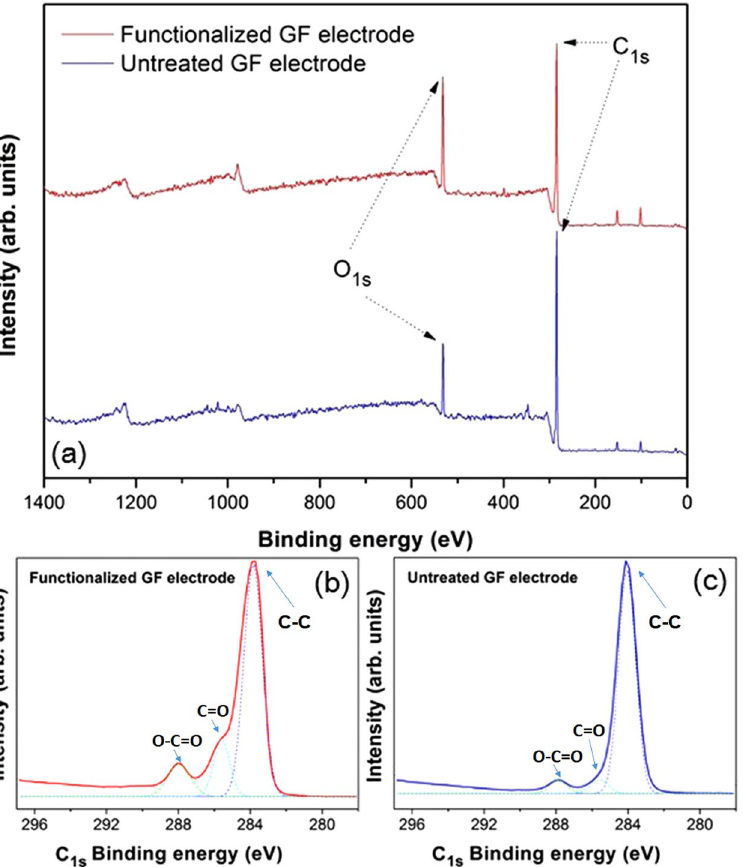
Figure 4. XPS spectra of full survey ( a ) and deconvoluted C 1s ( b, c ) binding energy region for graphene film electrodes before and after surface electrochemical oxidation, where solid and dash lines represent the experimental data and the single-peak gaussian profile of each designated binding energy region,